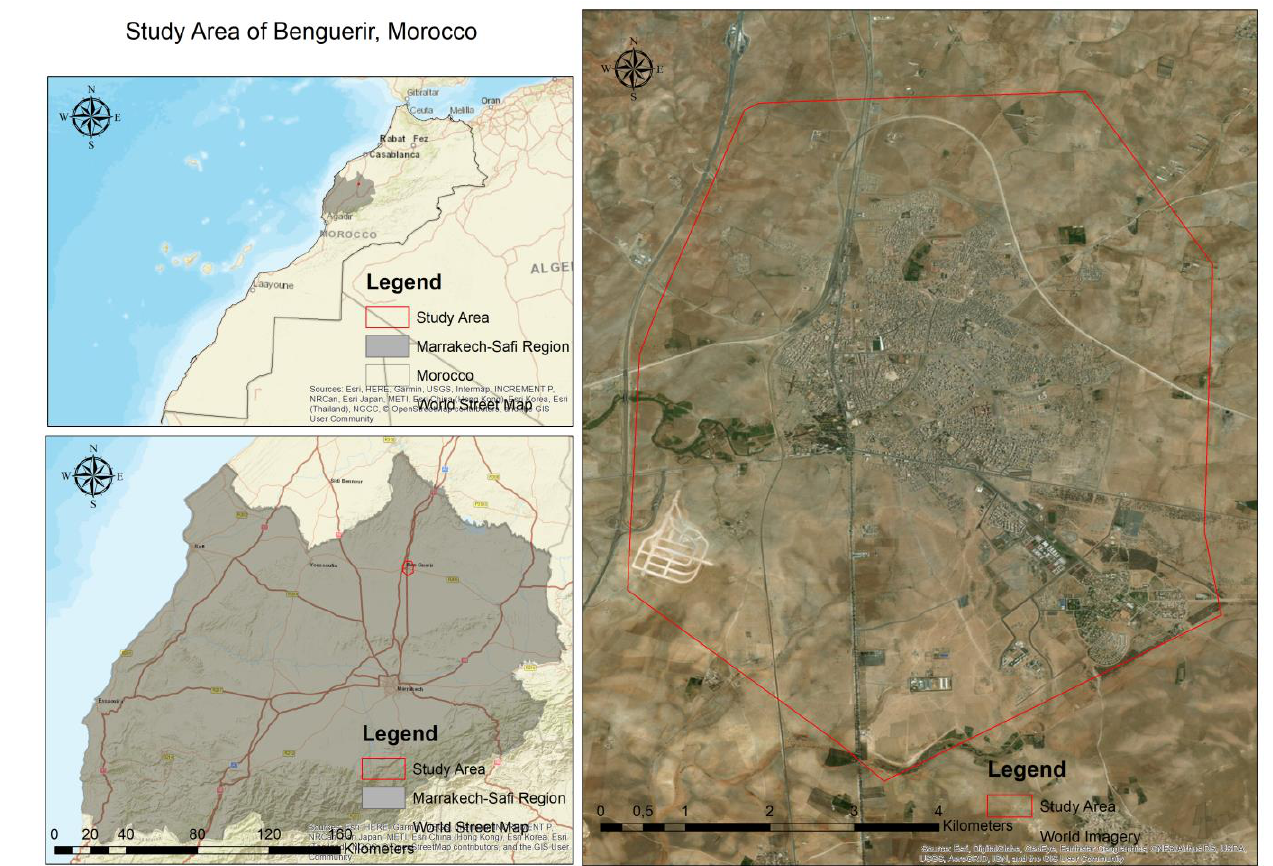
Figure 3. Study Area for Solar